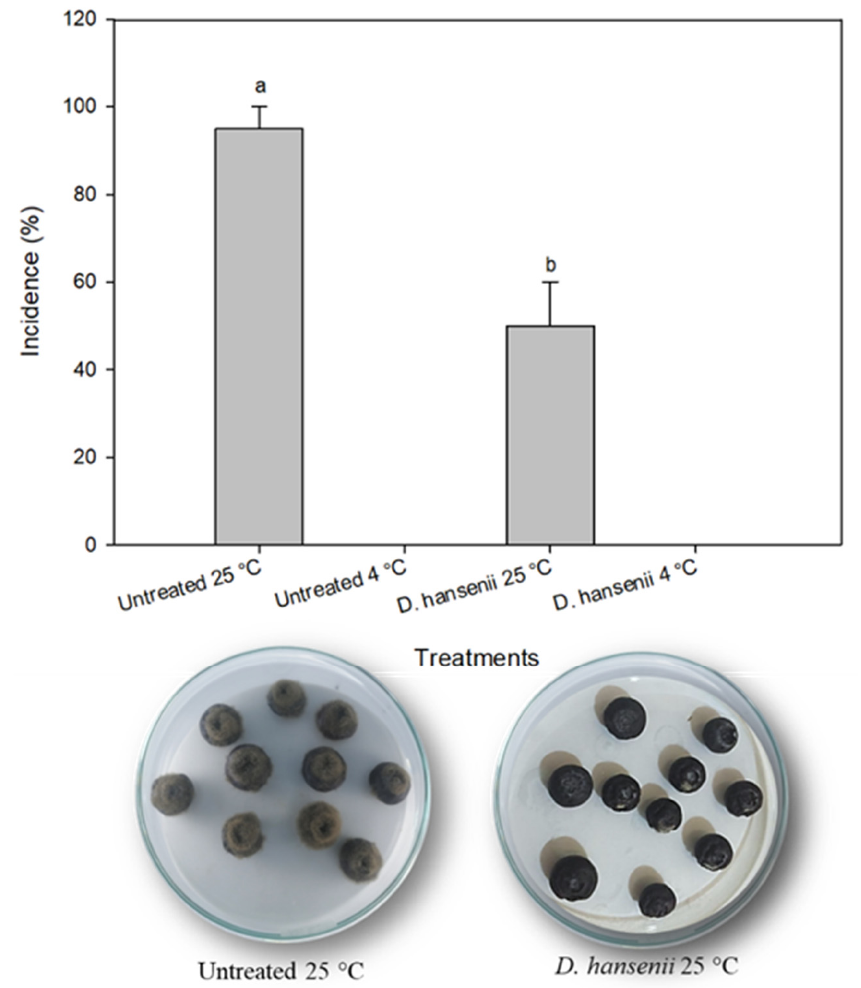
Figure 4. Incidence of B. cinerea on blueberries stored at 25 °C and 4 °C treated with D. hansenii . Different letters in the bars indicate significant differences between treatments at ( p < 0.05).